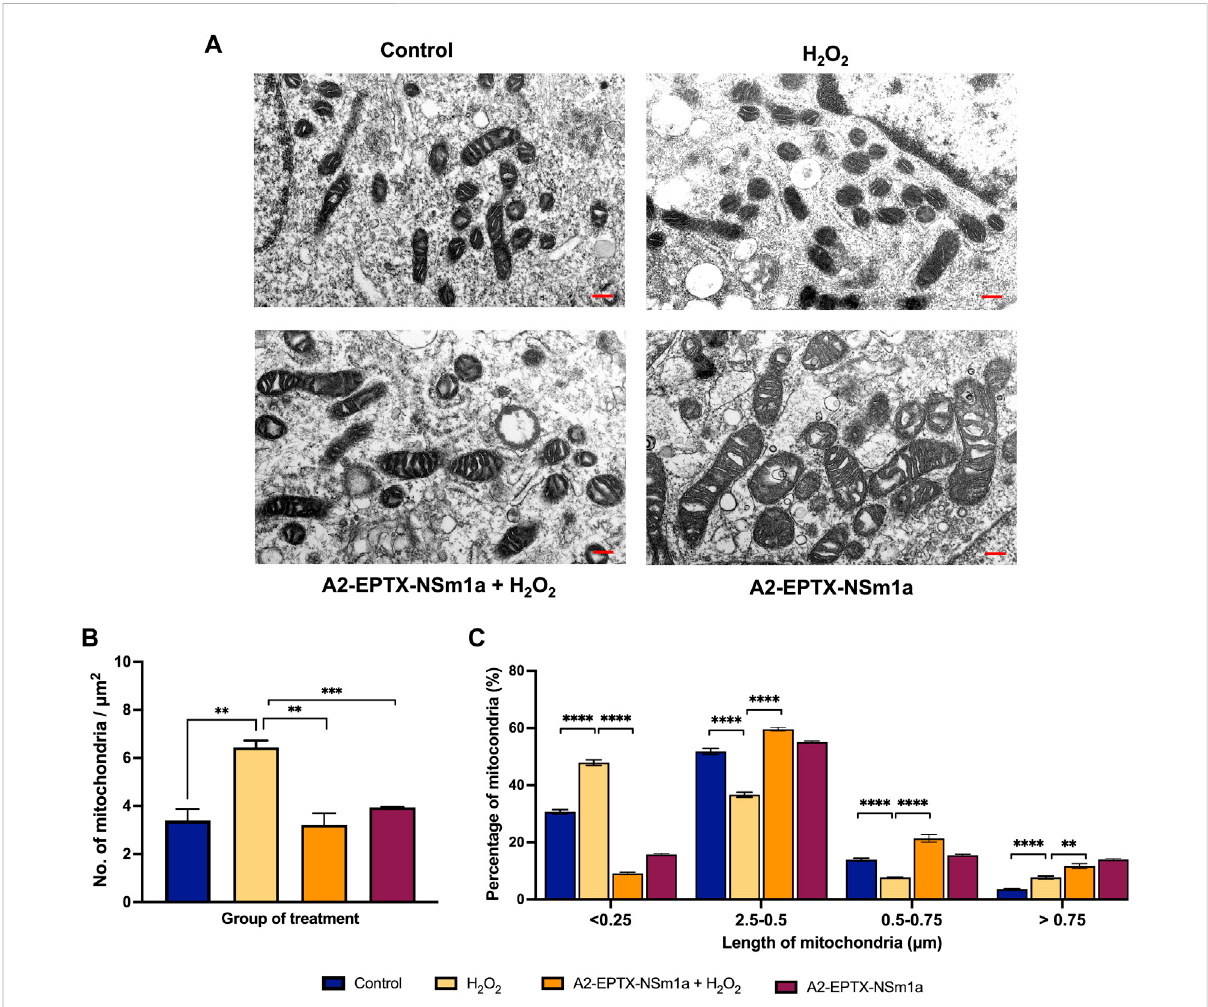
FIGURE 5 Observation of mitochondrial morphology from electron microscope. (A) Morphology of mitochondria in each group observed after 24 h of treatment ina representative ofcell. (B) Number ofmitochondria in the area has been quanti fi edand the length of mitochondria in each group were measured using ImageJ analysis. Scale bar = 200 nm. Data showed mean ± SEM and marked with ** indicating p < 0.01, *** as p < 0.005, and **** marked as p <